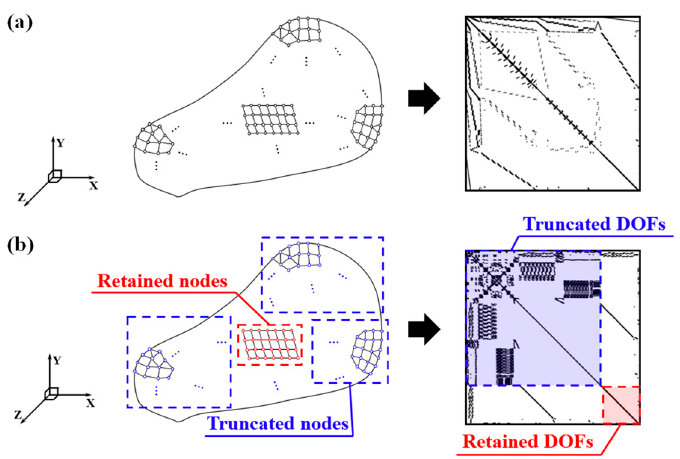
Figure 2. Partitioning of FE model: ( a ) Original FE model and its matrix, ( b ) Partitioned FE model and its re-ordered and partitioned matrix.